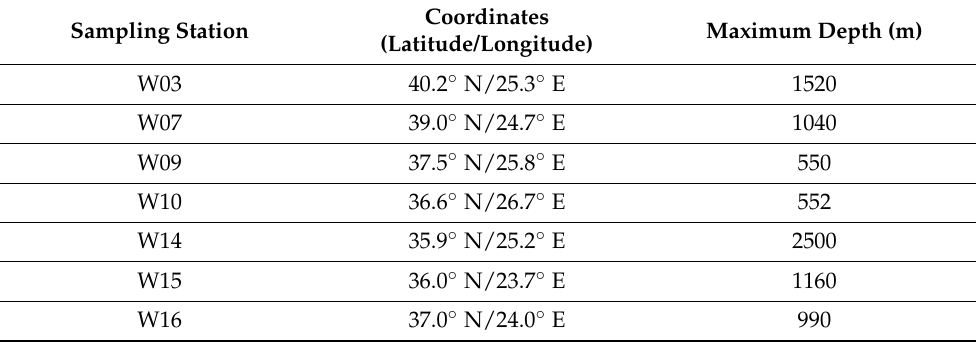
Table 1. Sampling station coordinates and maximum depths of the studied basins. Sampling